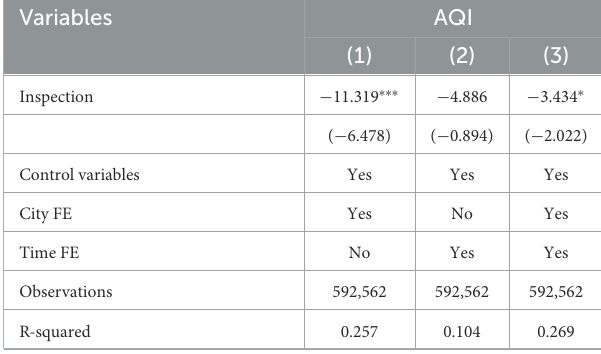
TABLE 6 Regression results based on the DID